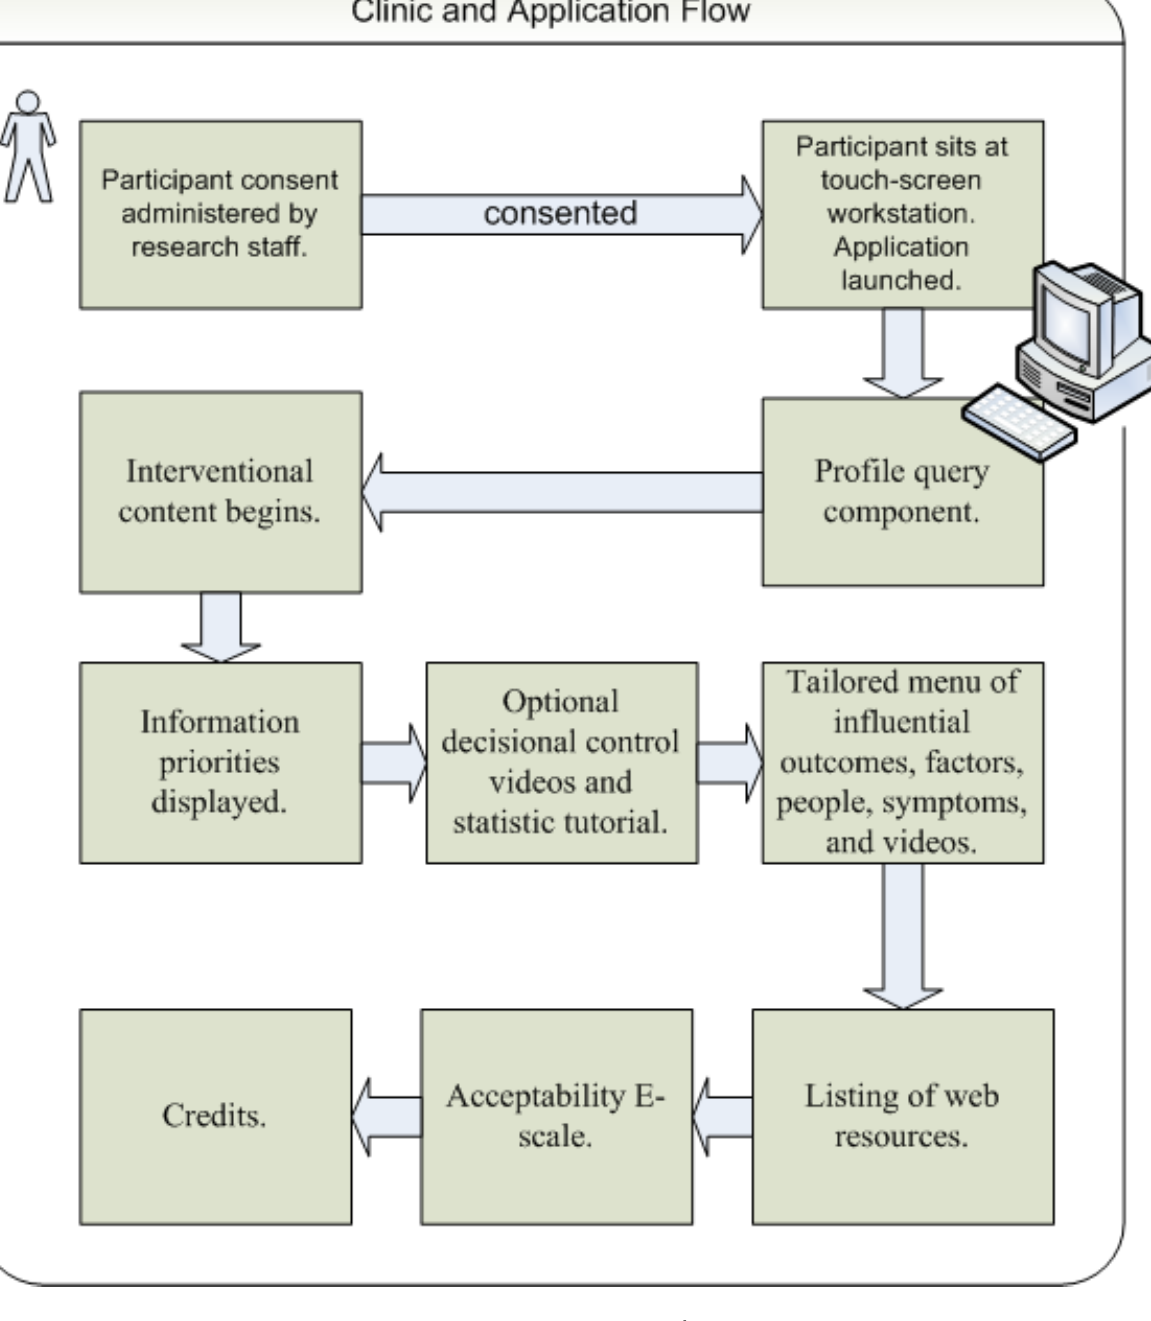
Figure 1. Clinical and application